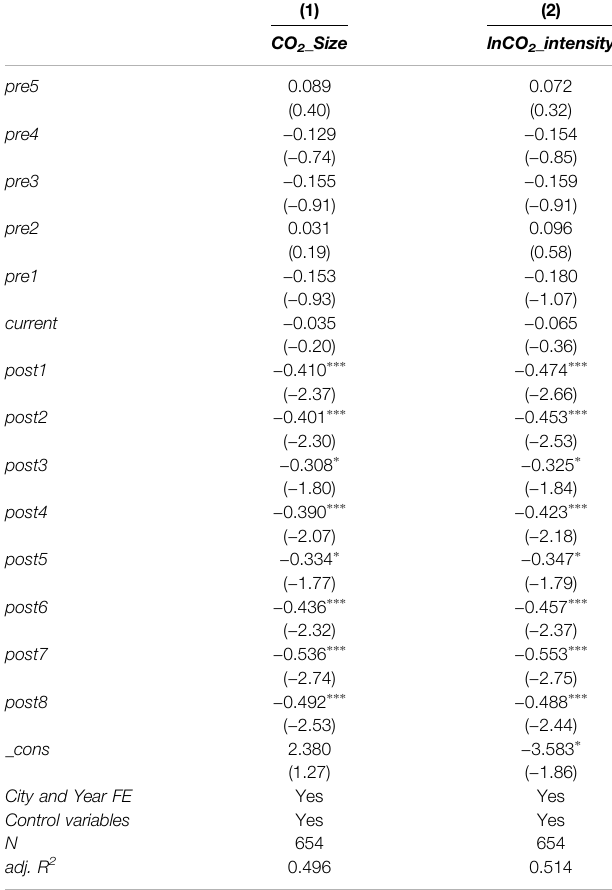
TABLE 5 | Parallel trend test and dynamic effect analysis.